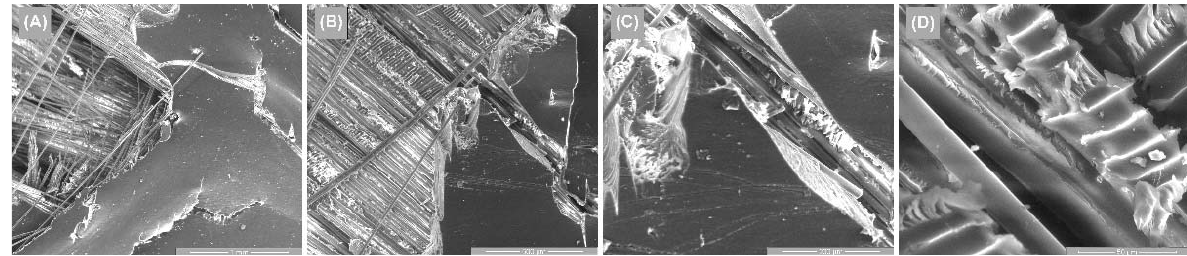
Figure 15. Surface SEM images of oriented at 45 GFRP sample: ( A ) 100×, ( B ) 200×, ( C ) 500×, and ( D )